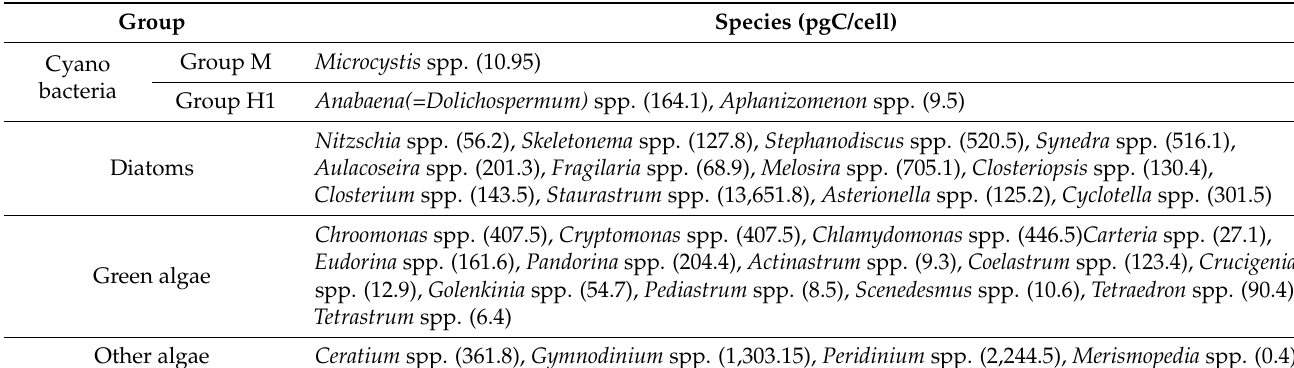
Table 2. Classification of algal species observed in the Nakdong River into groups and their respective carbon content per cell.